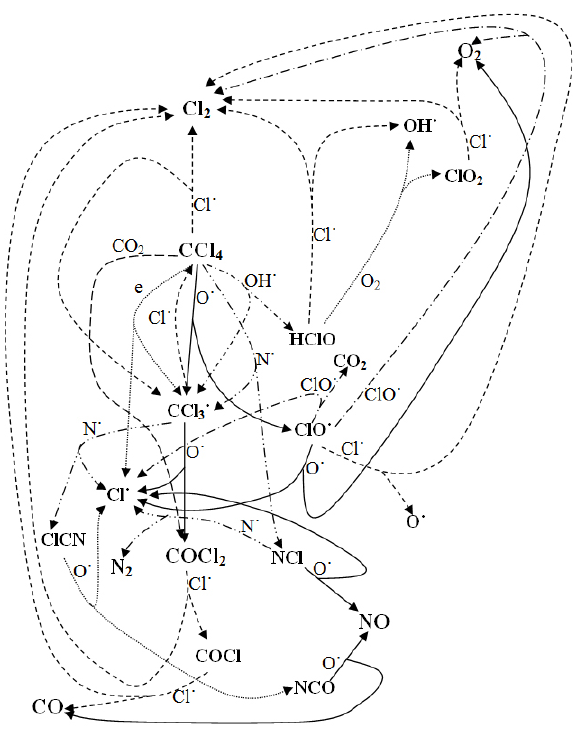
Figure 6 : The dependence between the CCl energy for the barrier